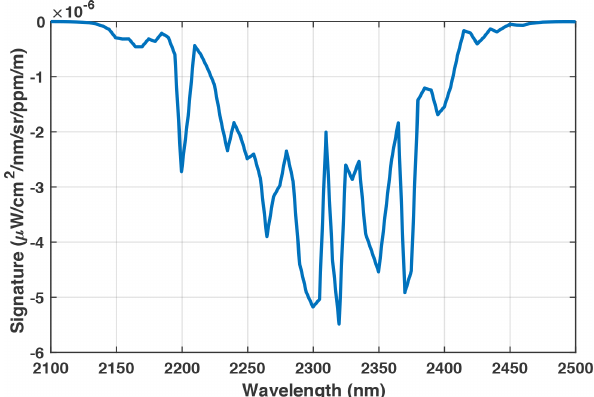
Figure 1. The target signature used for the matched filter